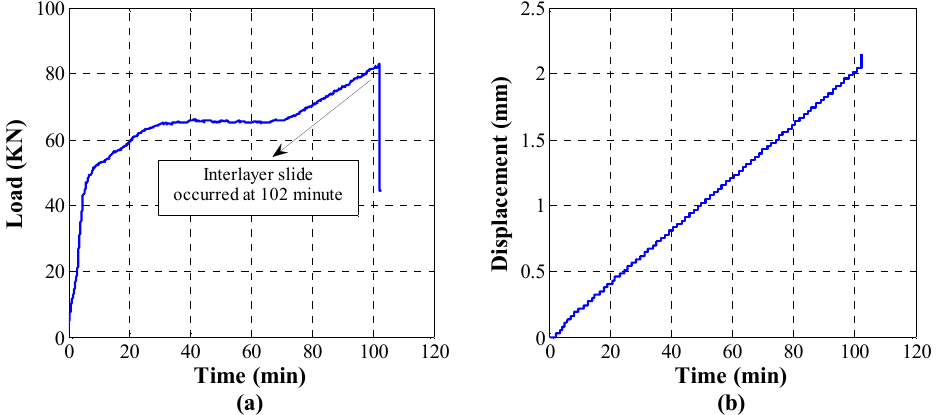
Figure 5. Loading history. ( a ) Load curve; ( b ) Displacement curve.